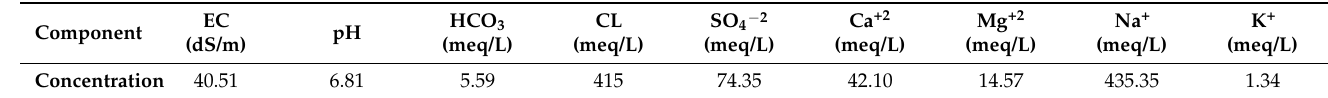
Table 1. A chemical analysis of